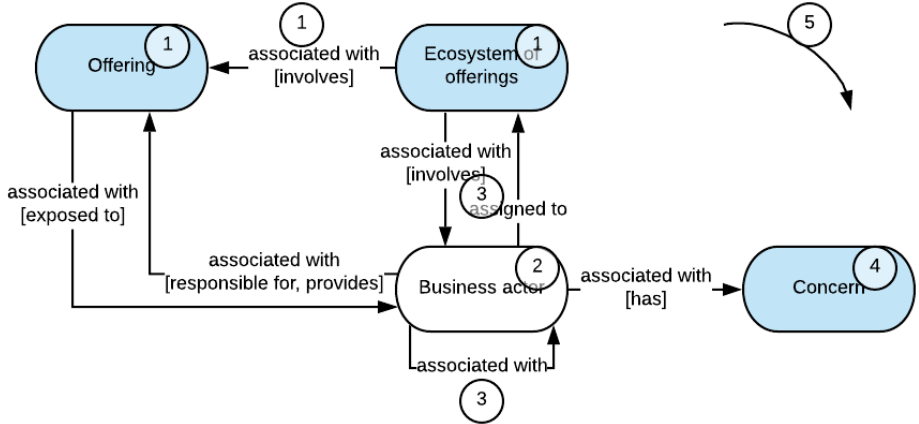
Figure 9. Procedures for modeling of ecosystem of